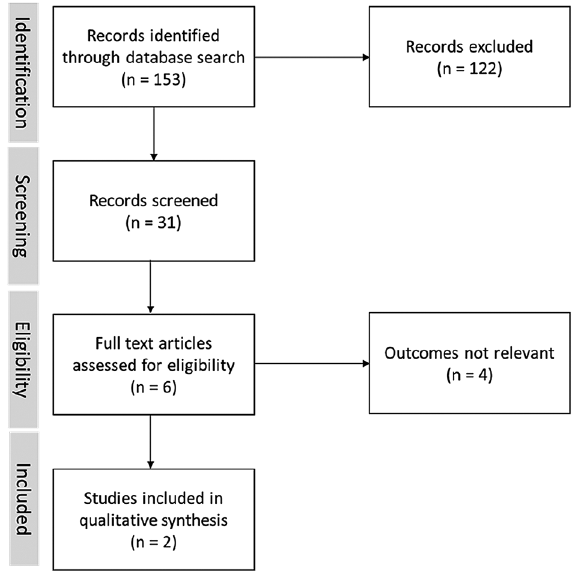
Figure 3. Paper search records.